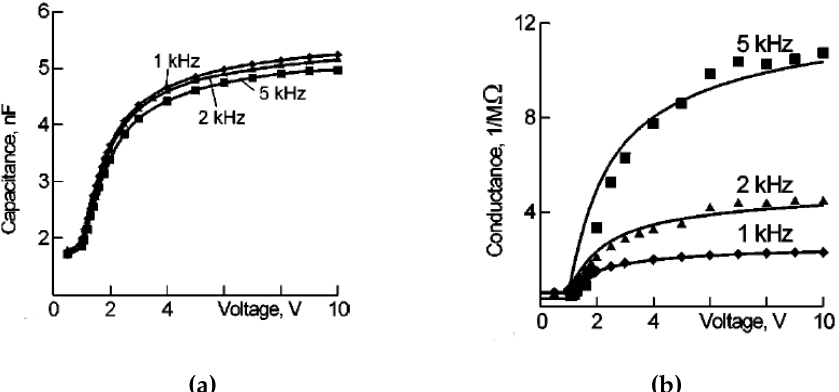
Figure 3. The cell capacitance and conductance for pure Liquid Crystal (LC) materials as function of the magnitude and frequency of applied voltage; ( a ) Capacitance modulation; ( b ) Conductance modulation [23].